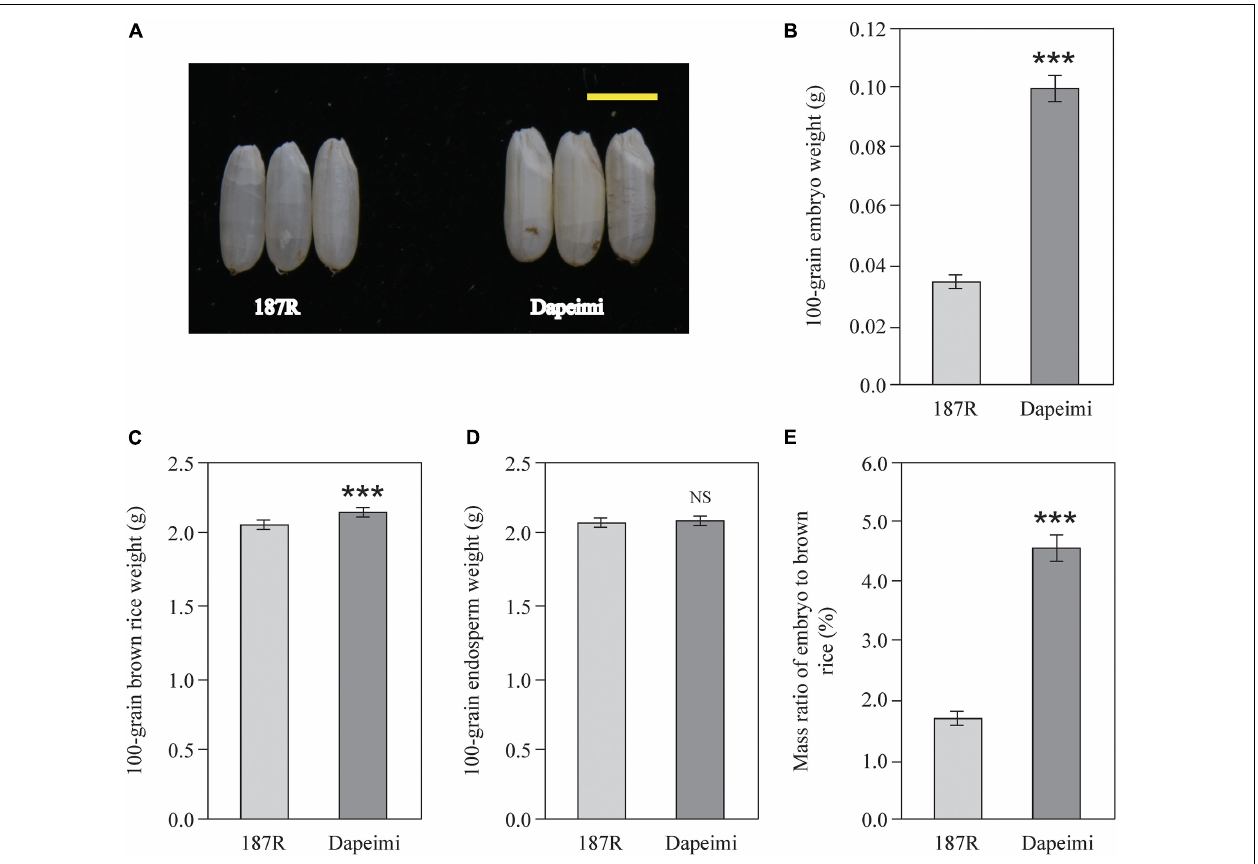
FIGURE 1 | Brown rice phenotypic characteristics of 187R and Dapeimi. (A) Brown rice of the parents used for gene mapping analysis. Scale bar, 0.5 cm. (B–E) Comparison of embryo weight (B) , brown rice weight (C) , endosperm weight (D) , and mass ratio of embryo to brown rice (E) between 187R and Dapeimi cultivars. Data are shown as means ± S.E.M. ( n = 3). *** P < 0.001; NS, not significant at P =